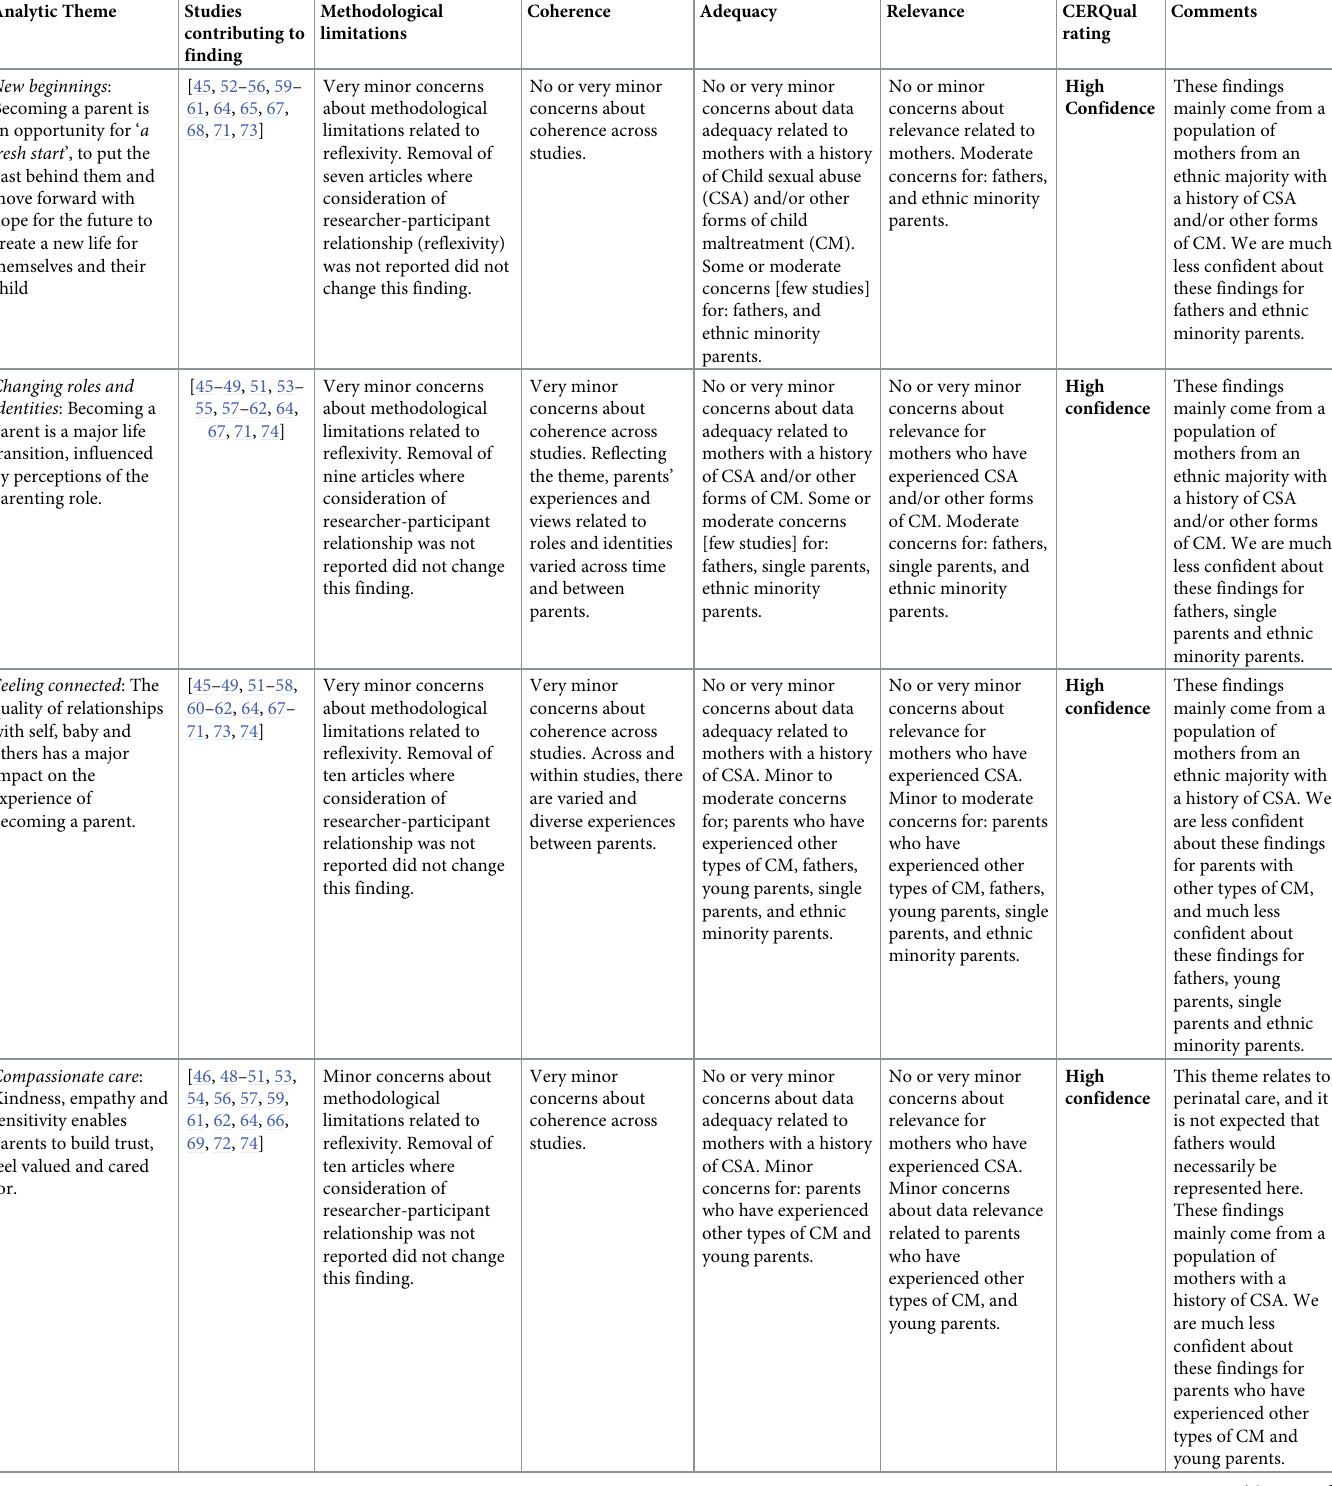
Table 2. Summary of findings and assessment of confidence in analytic themes using GRADE